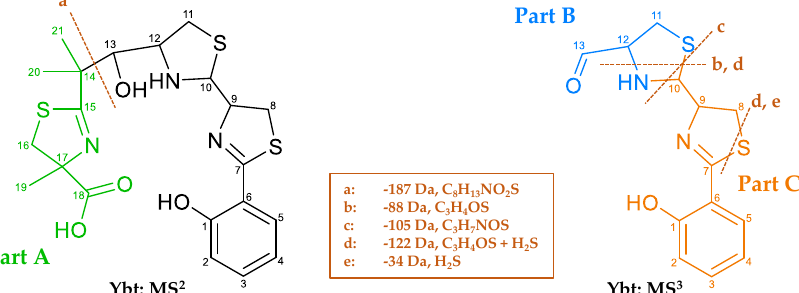
Figure 10. Fragmentation behavior of Ybt based on MS 2 und MS 3 experiments. Subdivision of the molecule into di ff erent parts: (part A), including C14 to C21, (part B) C11 to C13, and (part C) C1 to